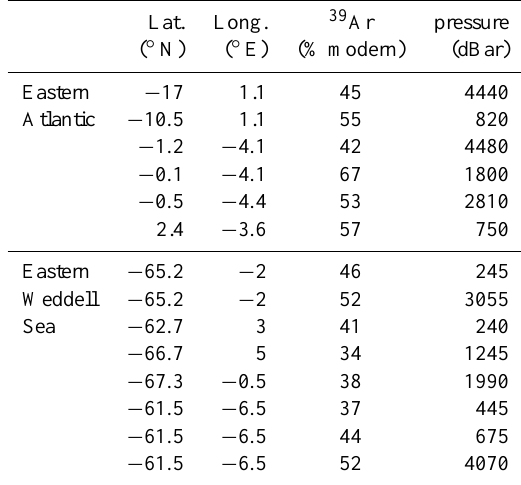
Table 2. 39 Ar data of the eastern Atlantic and southeastern Wed- dell Sea from the 1980s and early 1990s. The data are taken from Rodriguez (1993). Lat.